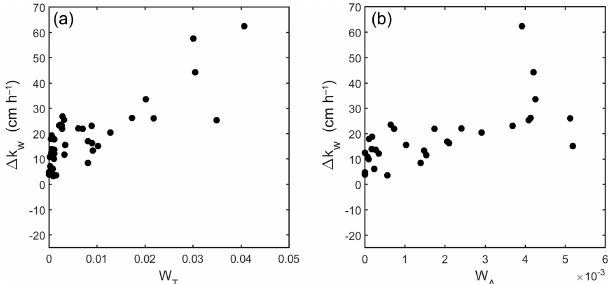
Figure 7. Knorr_11 (cid:49)k w data plotted against total whitecap areal fraction (a) and against Stage A whitecap areal fraction (b) . Each point is a 2h average of coincident measurements of whitecap frac- tion and DMS and CO 2 gas and k DMS ,Sc 2